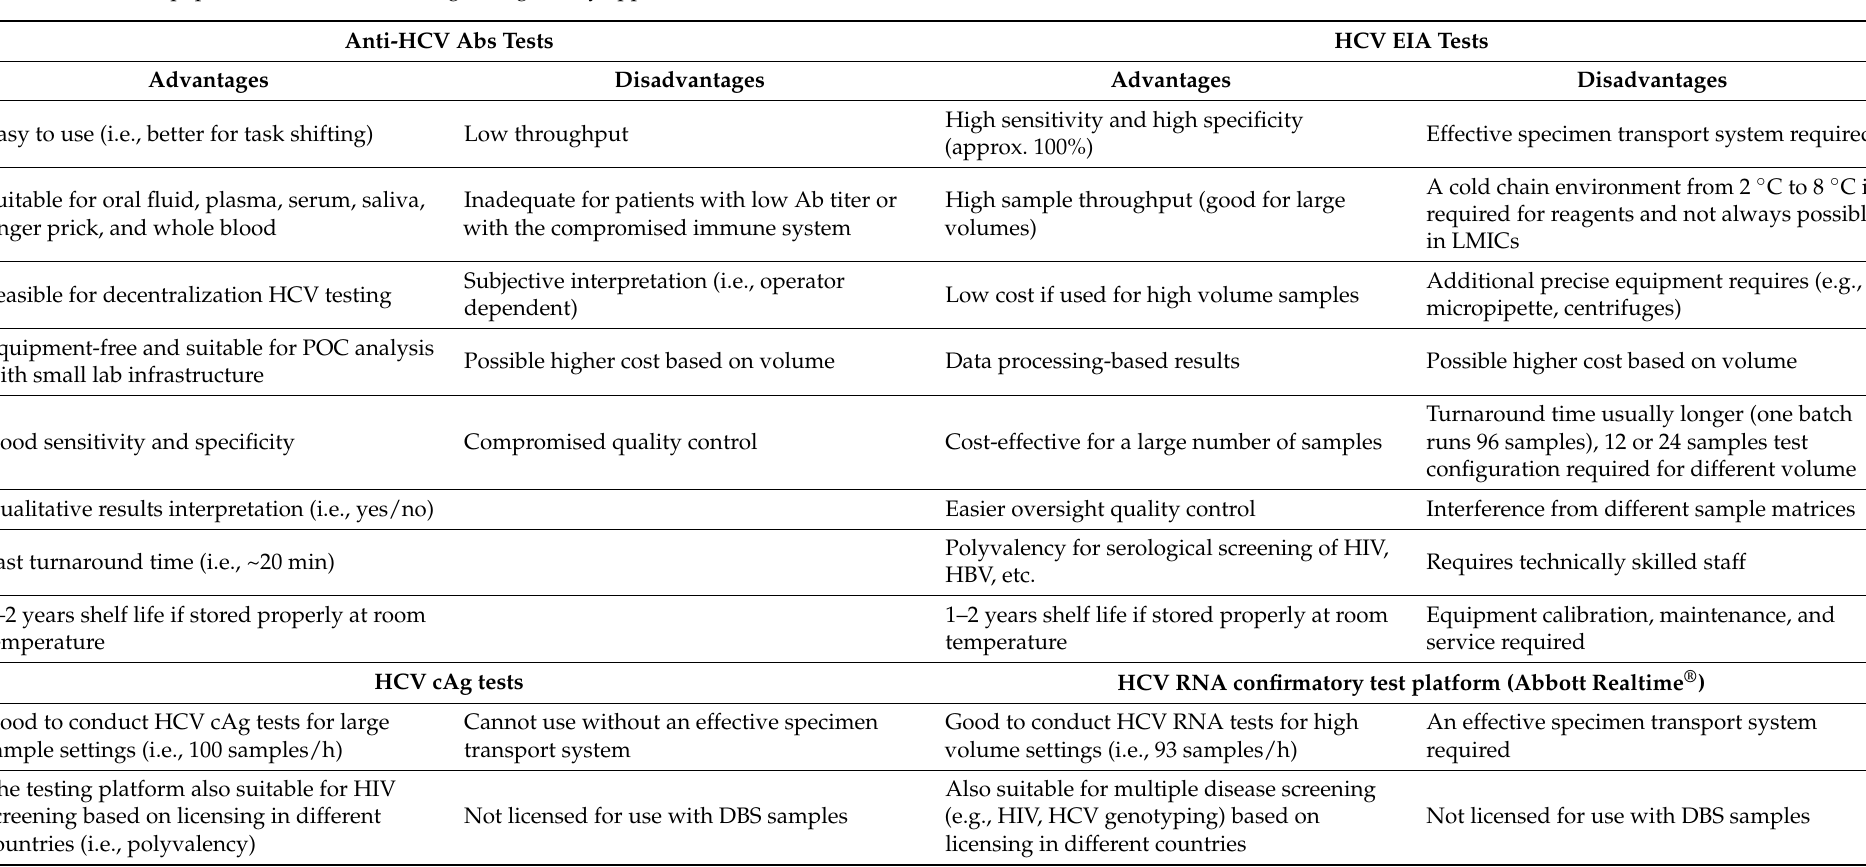
Table 1. The advantages and limitations of current and emerging HCV screening and diagnostic approaches. The table compares current and emerging HCV screening and diagnostic platforms in terms of their accessibility, affordability, durability, testing turnaround time, and cost-effectiveness [48]. Ab = antibody, POC = point-of-care testing, LMICs = low to middle income countries, LLoD = lower limit of detection, VL = viral load, FS = finger stick, DBS = dried blood spot, PQ = prequalification, CE = Conformit é Europ é enne, TB = tuberculosis, HPV = human papillomavirus, SRA = stringent regulatory